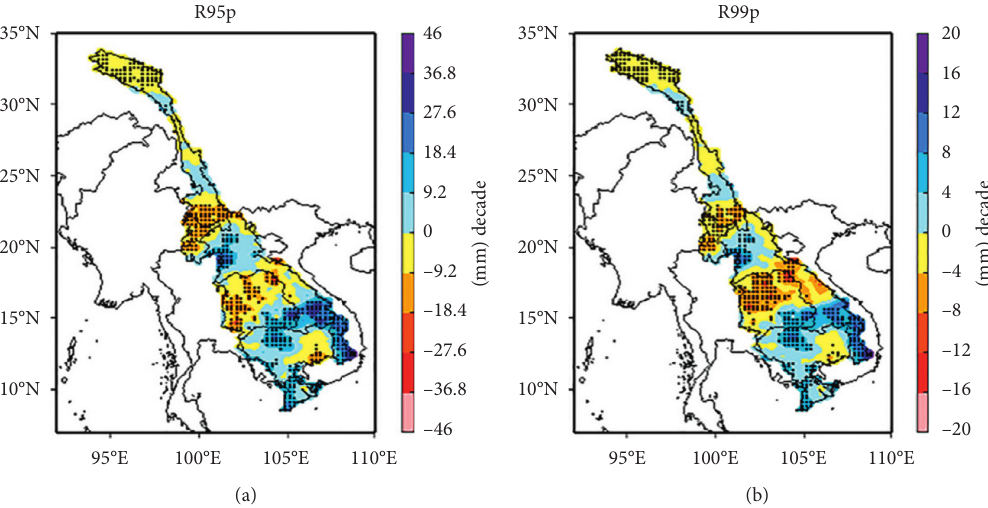
Figure 4: Spatial distribution of trend in R95p and R99p in the MB over 1951–2015. The black dots indicate that the trend in the grid is significant ( p < 0 . 05) under the Mann–Kendall